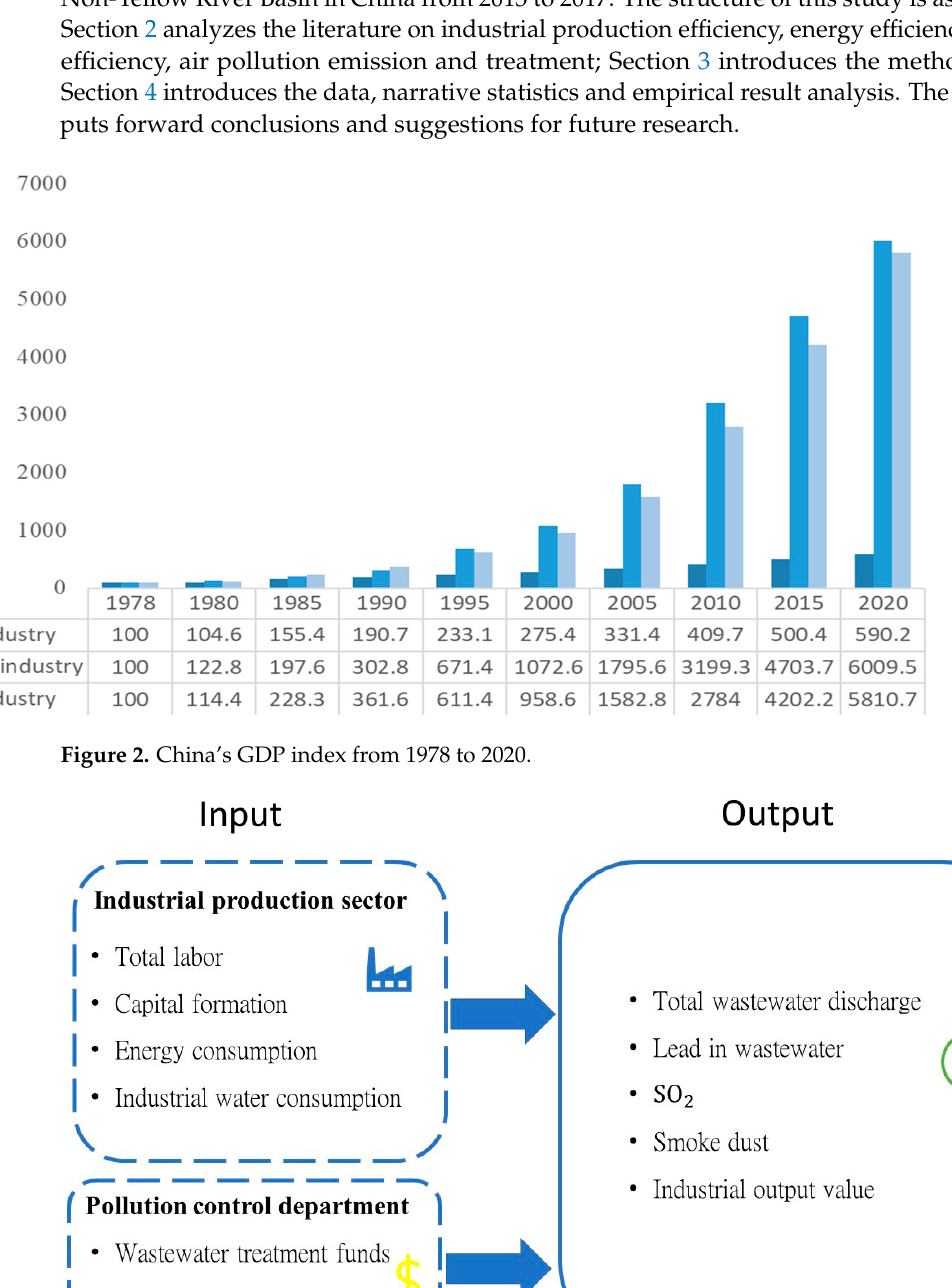
Figure 3. input and output process of variables in this study. Figure 3. Input and output process of variables in this